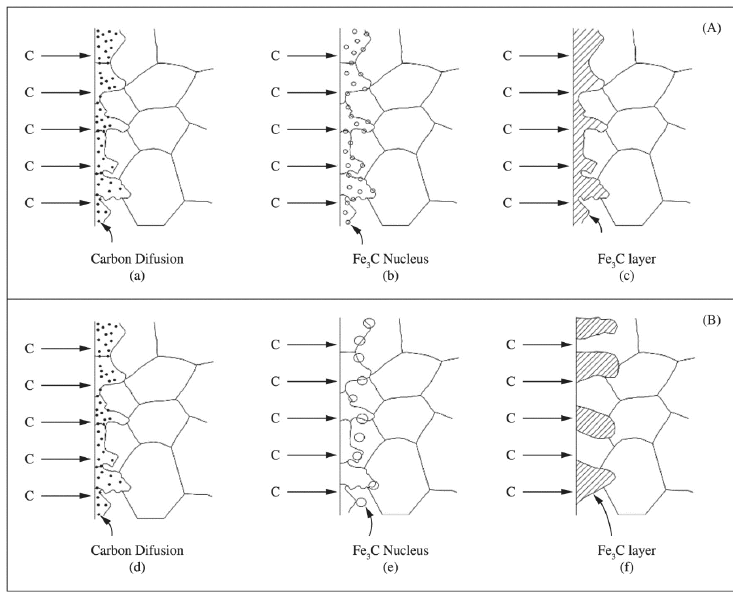
Figure 8. Schematic representation of the formation process of the cementite layer at 500 °C (A) and (B) 700 °C.